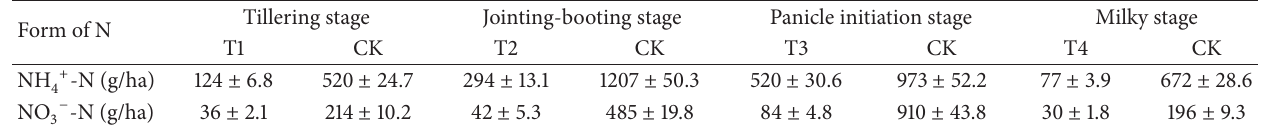
Table 3: Nitrogen loss by runoff during the period of submergence in 2010. Form of